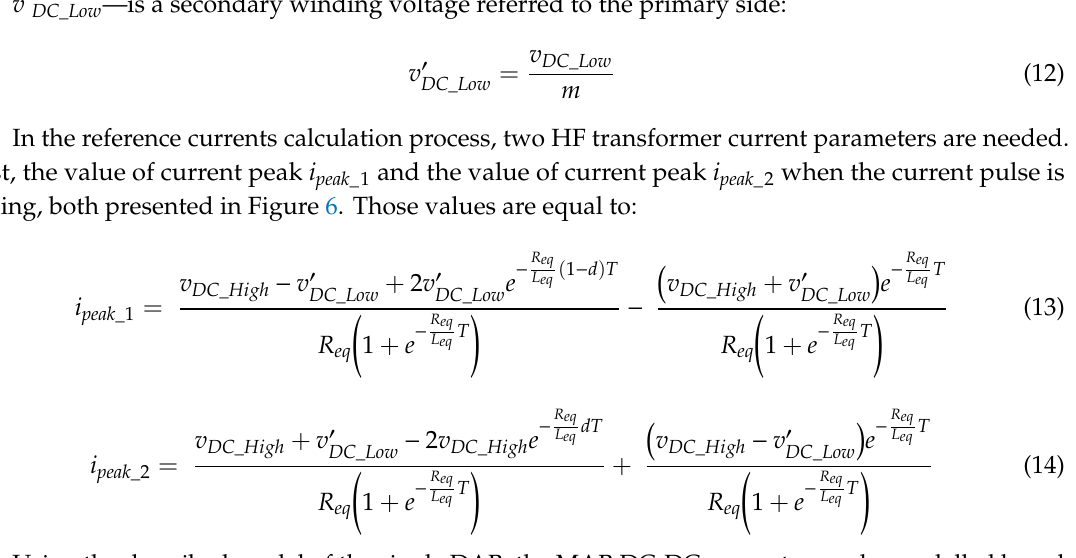
Figure 6. The waveform of the HF transformer current, when the phase-shift control is applied.